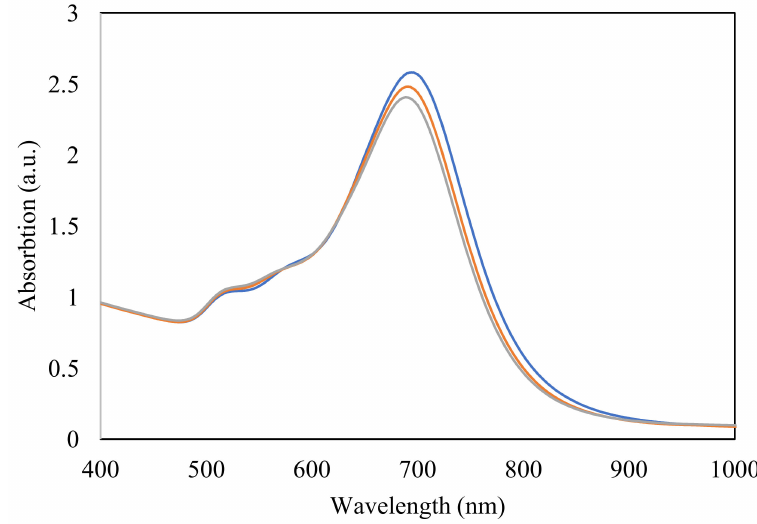
Figure 4. Absorbance spectra of GNBs right after synthesis (blue), and after 7 (orange), and 14 (grey) days of storage at room temperature.